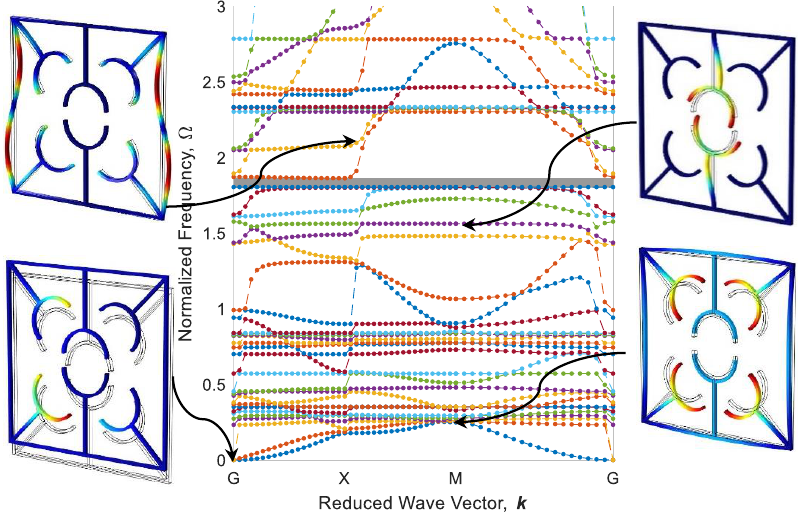
Figure 14. The counterpart of Figure 12 for 40 mm/s.